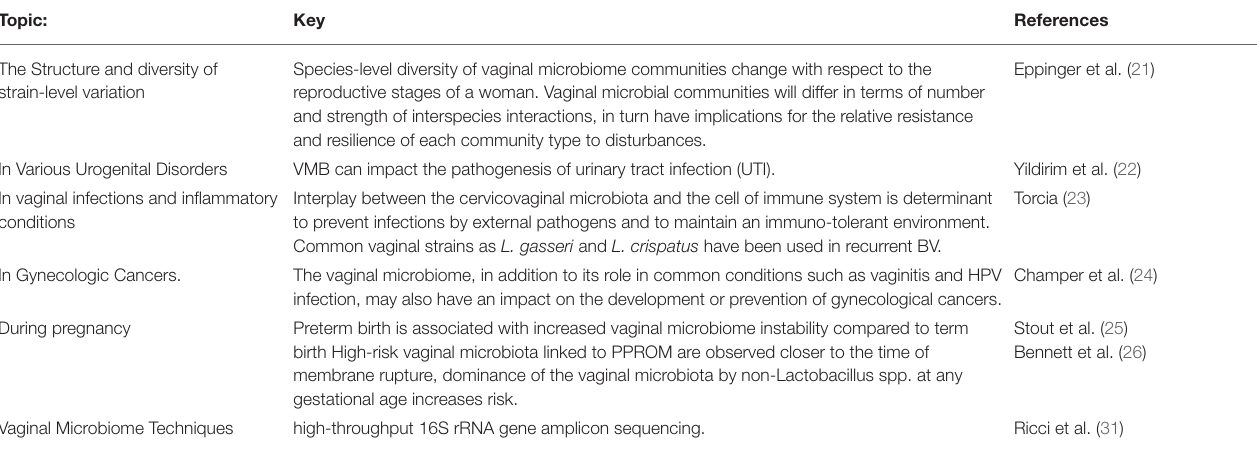
TABLE 2 | List of main associated literature in planning phase students prepared of Vaginal Microbiome.